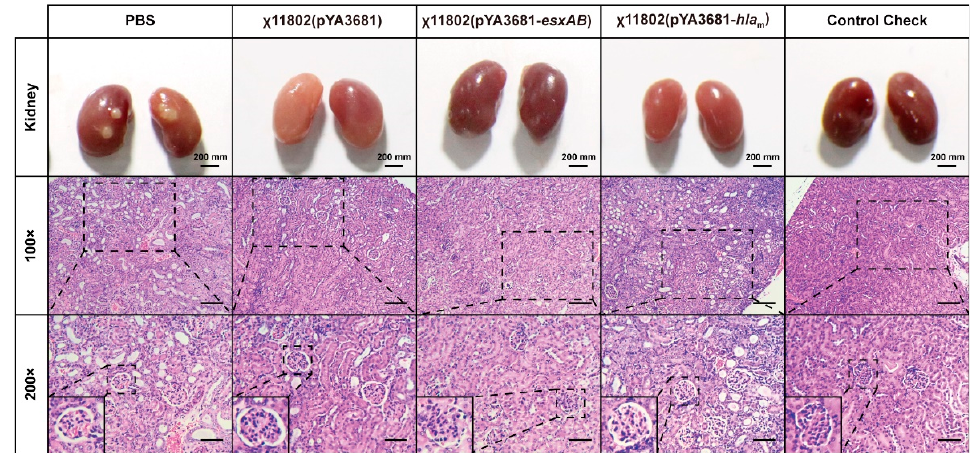
Figure 6. Histopathological evaluation of kidney after BALB/c mice were challenged with S. aureus USA300. Pathological section stained with H&E. The 100 × magnification with a 50 µ m bar. The 200 × magnification with a 100 µ m